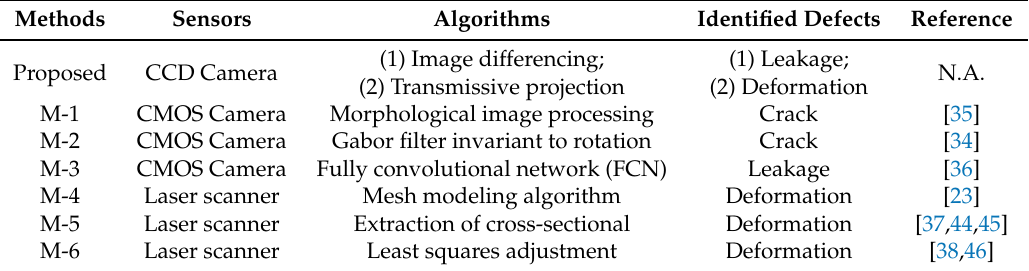
Table 4. Methodologies of state-of-the-art works.